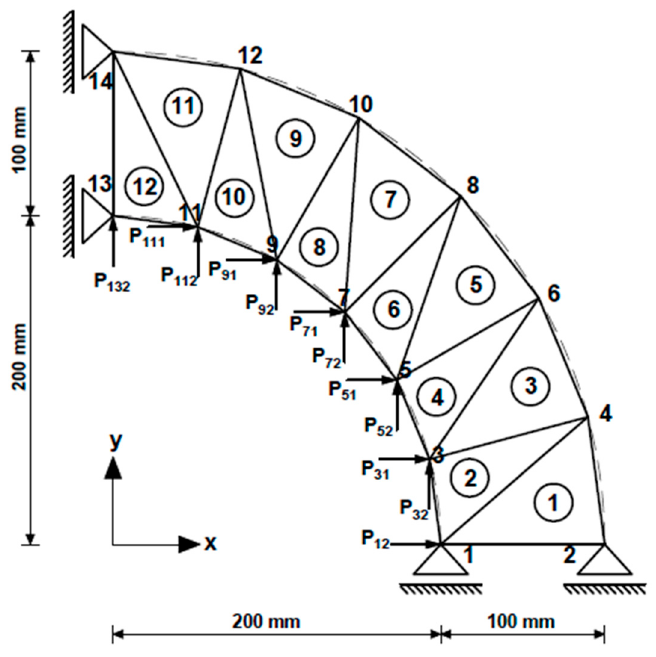
Figure 5. Model of the system with 12 members-14 nodes.